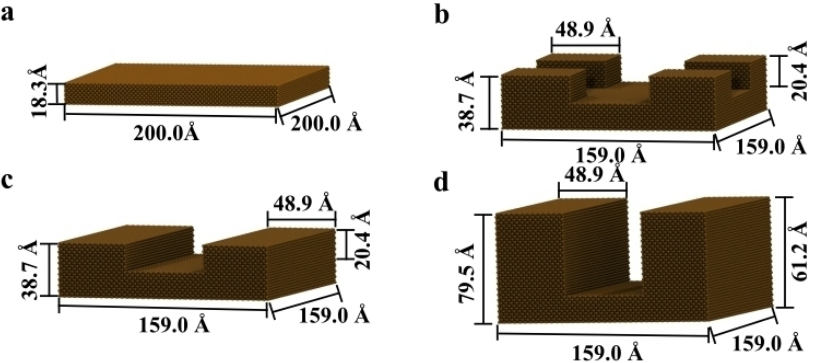
Figure 2. Different nanoscale topographies: ( a ) flat (FLT); ( b ) pillars (PLR); ( c ) shallow linear grating (SLG); (d) deep linear grating (DLG).